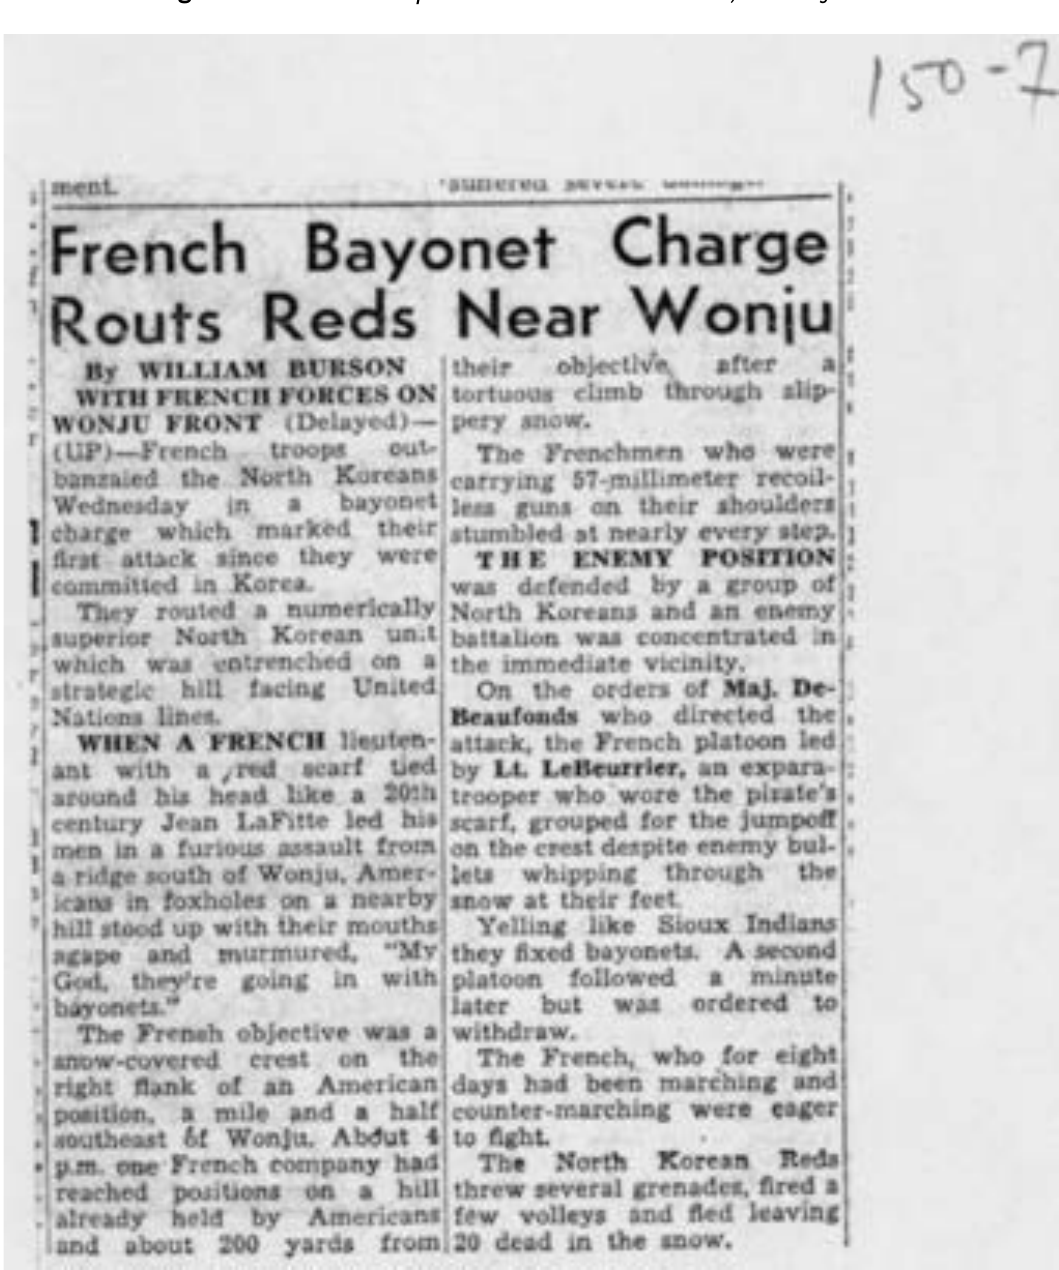
Figure 2. Stars & Stripes Pacific Edition article, January